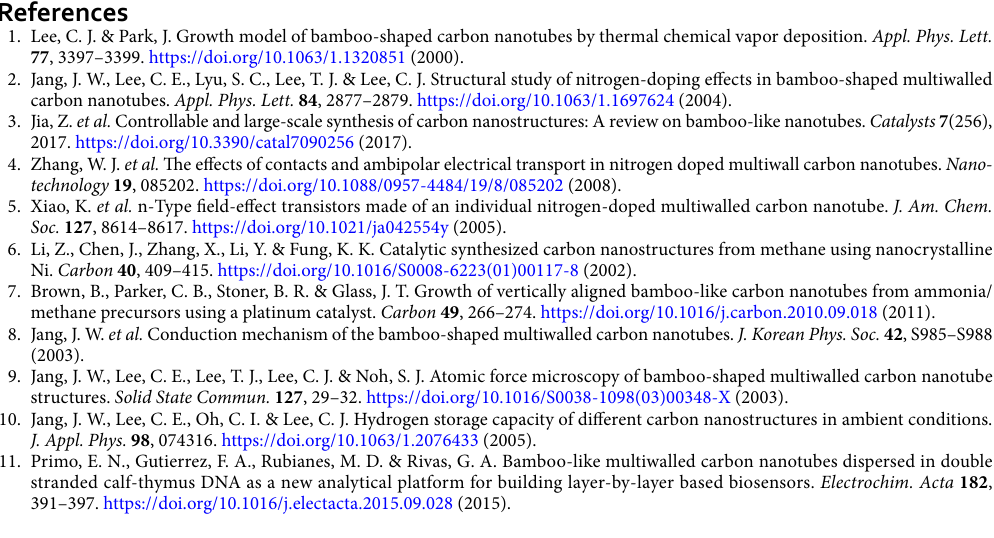
Figure 4. ( a ) A scanning electron microscopy (SEM) image of a bamboo-shaped multi-walled carbon nanotube (BS-MWCNT) on highly oriented pyrolytic graphite (HOPG). ( b ) An atomic force microscopy (AFM) topographic image (Topo.). ( c ) A respective contour plot of ( b ). ( d ) A line profile obtained from the dark grey line in ( a ). ( e – f ) LFM images measured with scanning from ( e ) left-to-right (LR) and ( f ) right-to-left (RL). ( g ) Line profiles obtained from the red and blue lines in ( g – f ). The x-axis of the line profile graph is matched with ( g ). ( h ) A subtracted LFM image (LR − RL). ( i ) A respective contour plot of ( h ). ( j ) A line profile obtained from the magenta line in ( h ). ( k ) An added LFM image (LR + RL). ( l ) A respective contour plot of ( k ). ( m ) A line profile obtained from the olive line in ( k ). Measurements for Topo., LR, RL, LR − RL, and LR + RL are carried out on the white-box area in ( a ). The directions to the tail and head of the BS-MWCNT are denoted with arrows. The groups of the yellow boxes in ( c , i , l ) have been placed at the same positions. The yellow arrows in ( d , g , j , m ) indicate the same positions. The black dashed line in ( g , j , m ) indicates zero